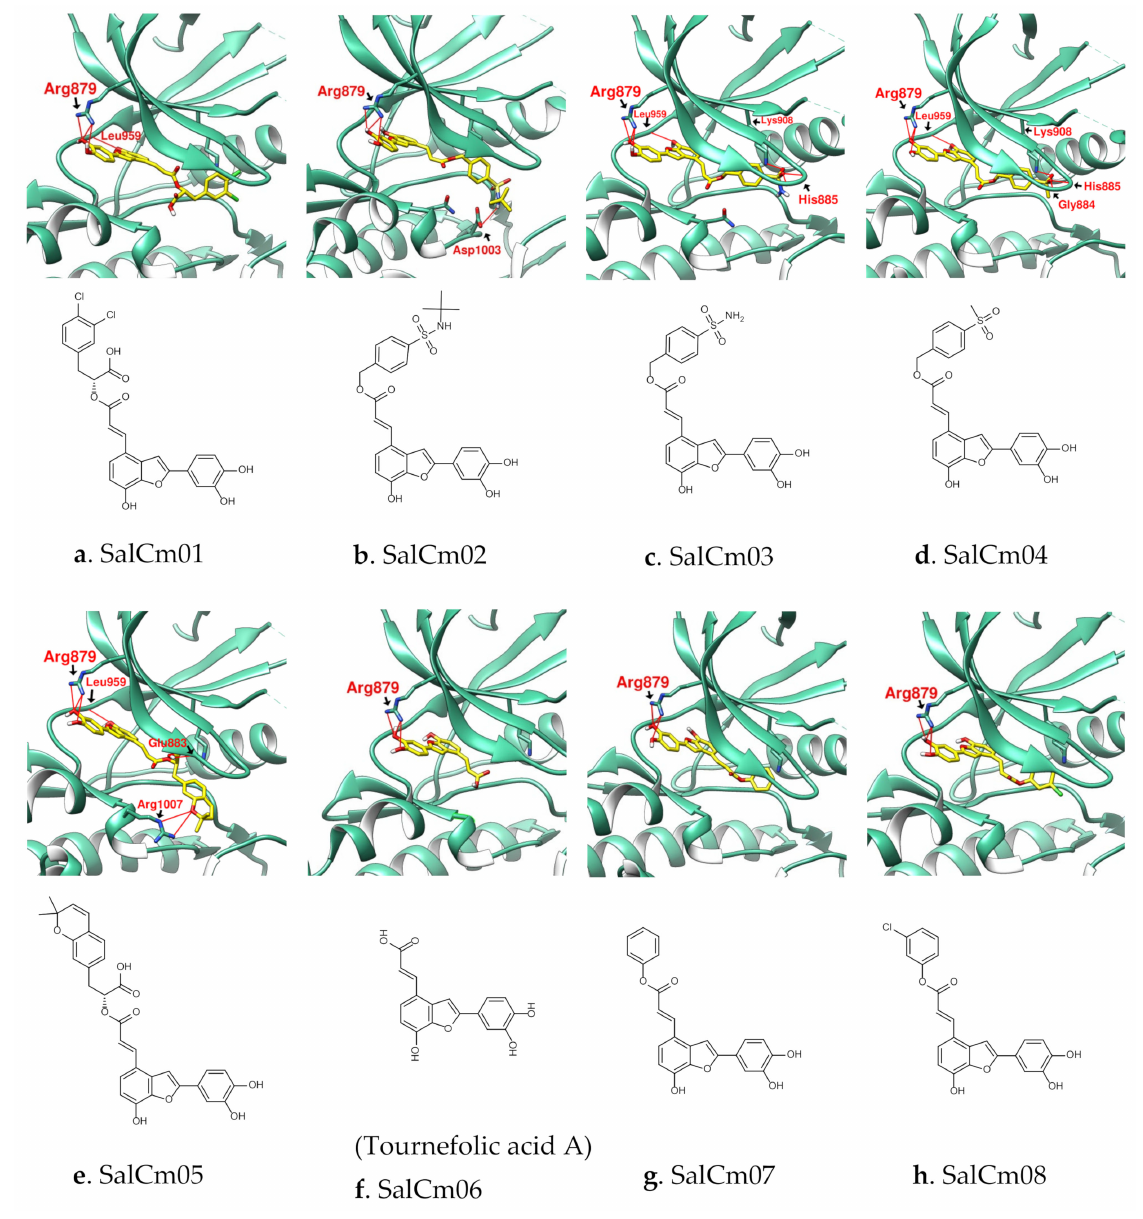
Figure 6. ( a – h ) SalCm01~SalCm08 were designed with reference to the structure of SalC in order to obtain better ADME parameters or binding affinity to JAK than SalC. Hydrogen bonds were shown as red lines with amino acid residue